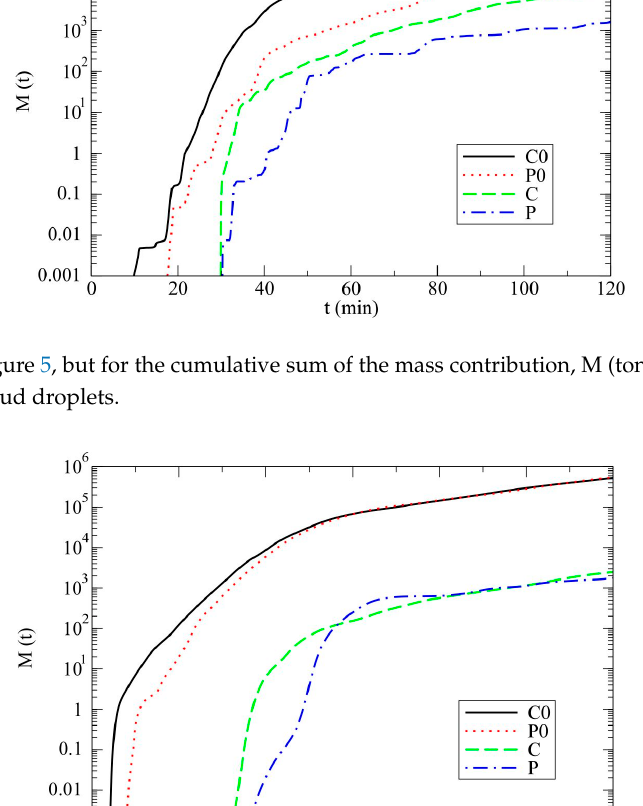
Figure 8. As in Figure 5, but for the cumulative sum of rain evaporation (tonnes).